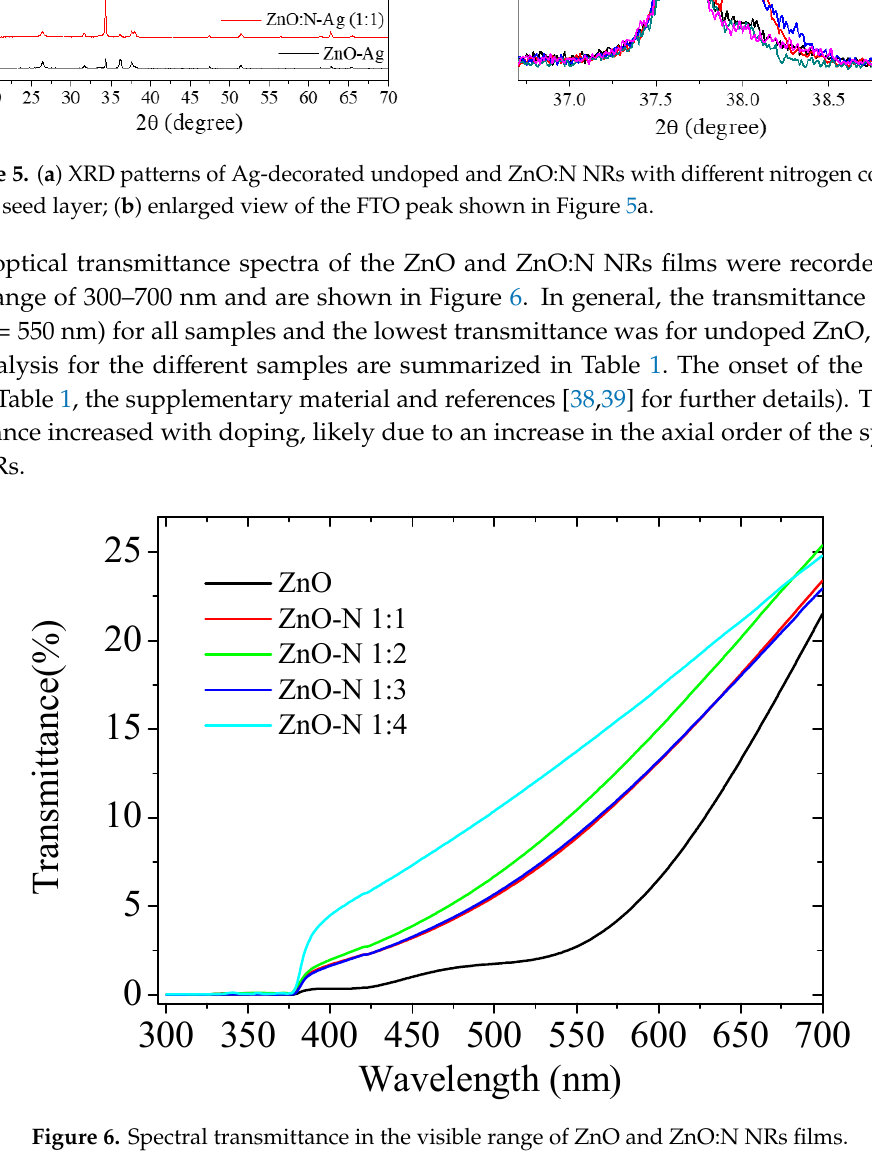
Figure 6. Spectral transmittance in the visible range of ZnO and ZnO:N NRs films.